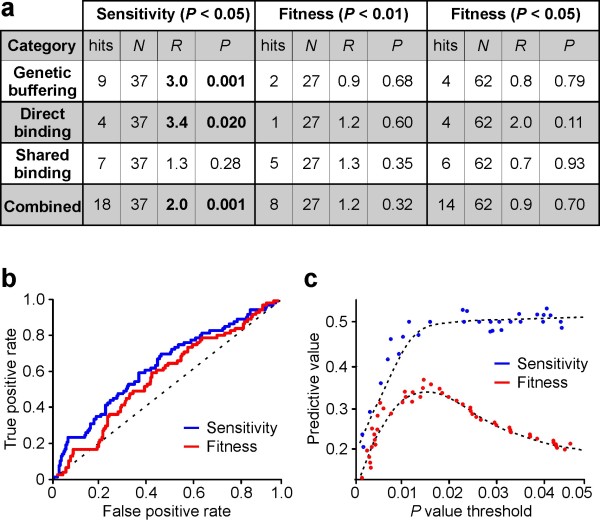
Statistical comparison of genetic interaction sets. (a) Genetic buffering and genome-wide TF-DNA binding data (Workman dataset) is taken for evidence of putative regulatory relationships among TFs. R gives the fold enrichment defined as a ratio of frequencies relative to a random model, and P the probability of observing a ratio of equal or greater value by chance. Boldface is used to indicate statistically significant enrichments (P < 0.05) within the genetic interaction sets relative to the frequency (hits/N) of interactions within the Workman data. Enrichment is analyzed in four categories: (1) Genetic buffering of one TF by another, (2) Direct binding of one TF to the gene encoding another, (3) TF pairs that bind to the same target gene(s), (4) interactions supported by any of the categories (1)-(3). The number of hits in the Workman dataset among the 316 pairs tested for each category are 26, 10, 46 and 77, respectively. (b) Comparison of true- and false-positive rates associated with each methodology. (c) The predictive value of the fitness- and sensitivity-based methods at different P value thresholds. The predictive value is defined as the fraction of correctly identified interactions.